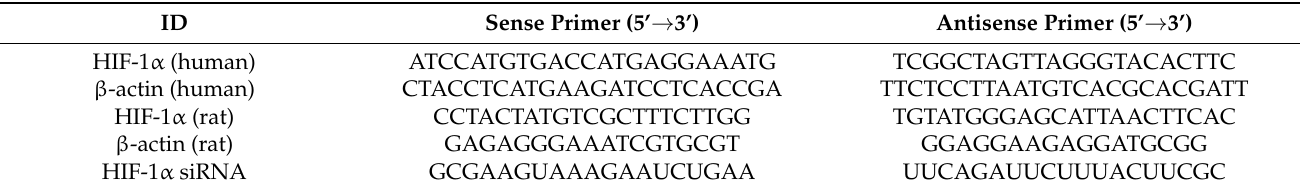
Table 1. Primer and siRNA